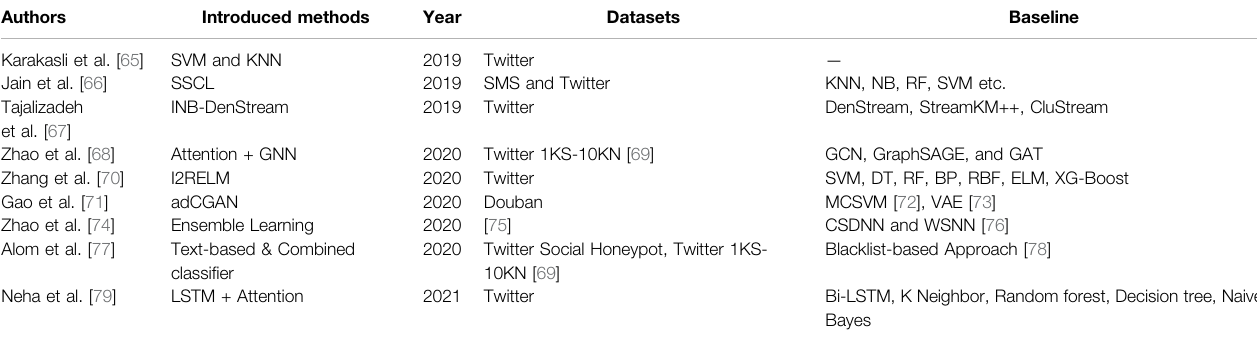
TABLE 3 | Machine learning in spam